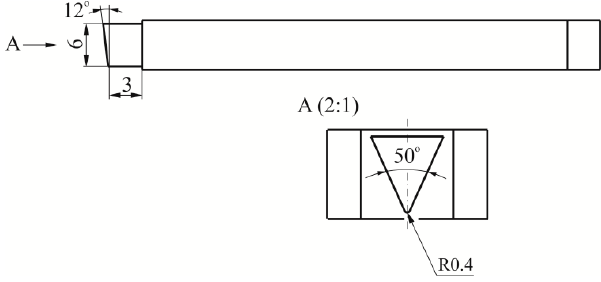
Figure 3. The basic geometry of the punch blanking tool.